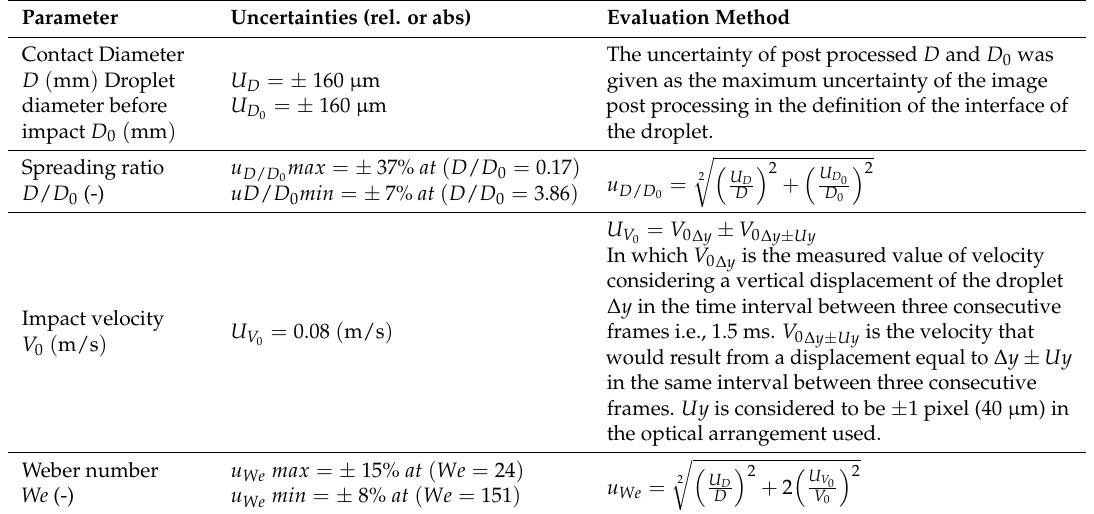
Table 2. Uncertainties of the measured parameters used for the droplet dynamic characterization Parameter Uncertainties (rel. or abs) Evaluation Method Contact Diameter D ( mm ) Droplet diameter before impact D 0 ( mm ) Spreading ratio D / D 0 (-)